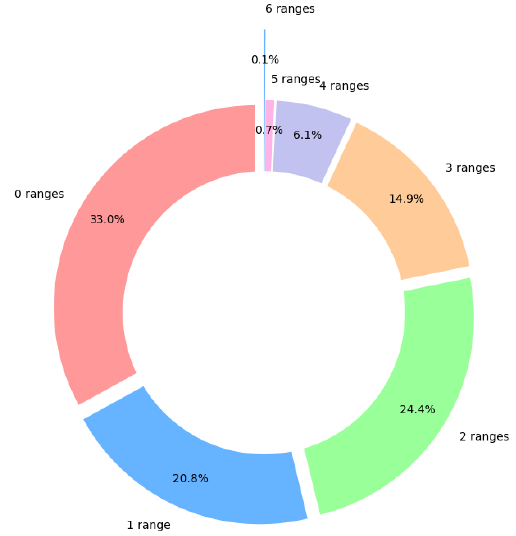
Figure 10. V2I UWB TimeDomain network: number of measurements available simultaneously in a loop (percentage of cases).